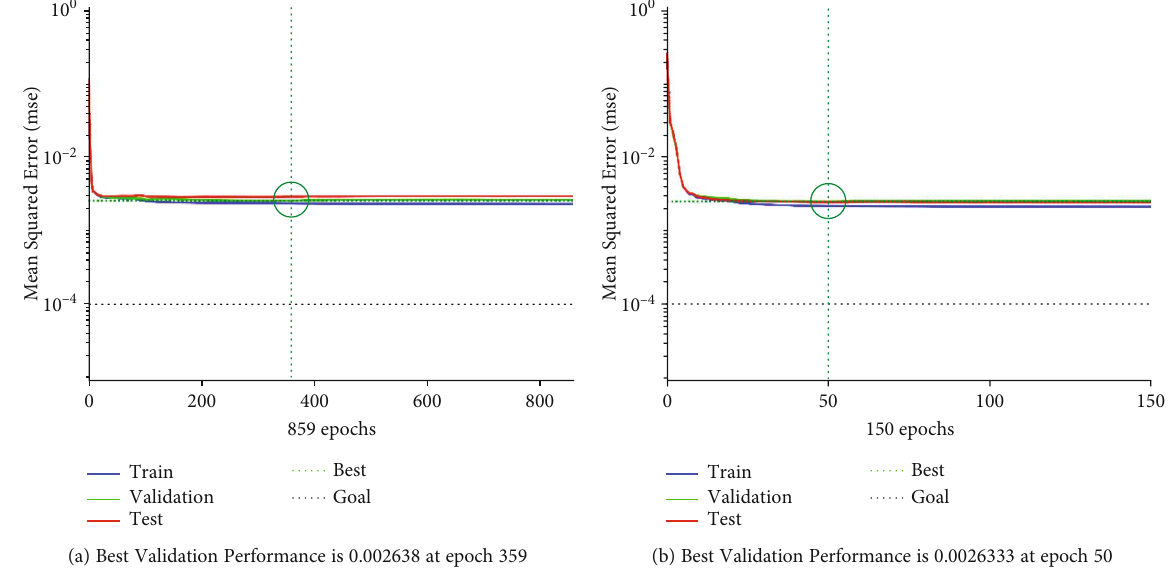
Figure 8: The MFFNN performance plots of best models: (a) Isparta and (b)